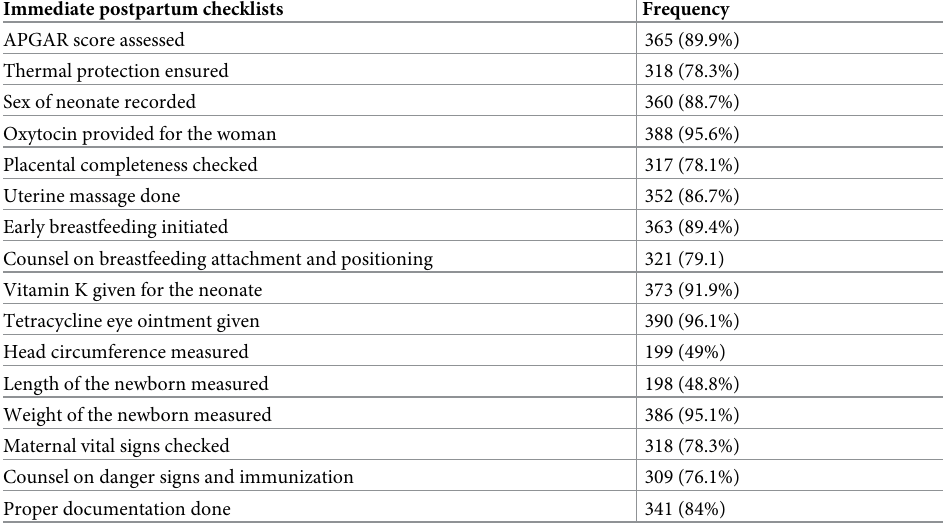
Table 3. Adherence to immediate postpartum care checklist among health care providers at hospitals in Gondar province northwest Ethiopia,